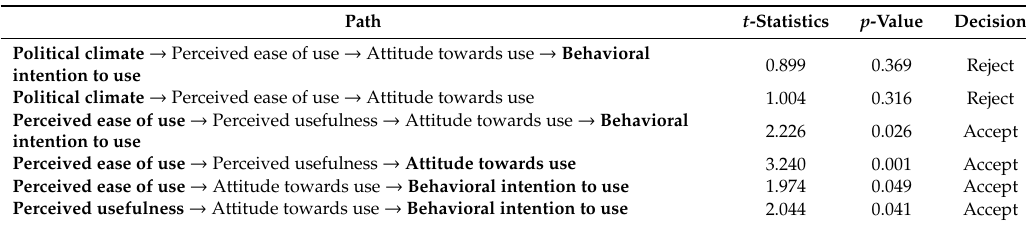
Table 9. Indirect e ff ects of the mediating variables (for RWHS with